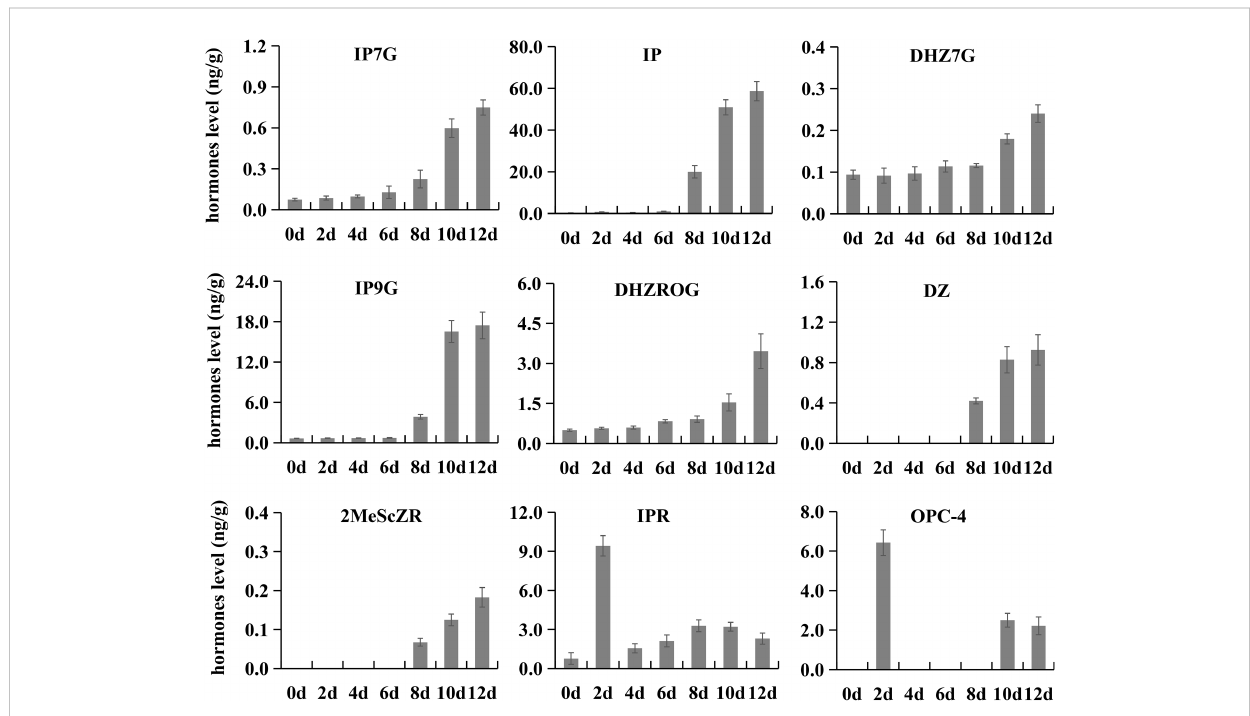
FIGURE 4 Contents of nine hormones at different postharvest ripening stages. Error bars represent standard deviations from three